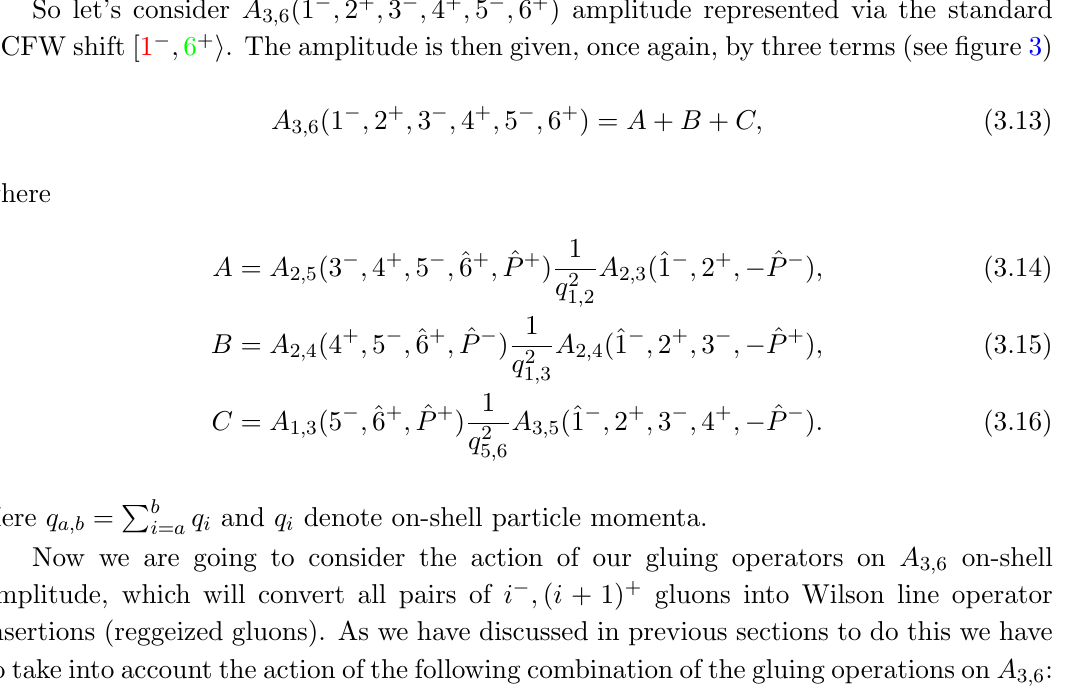
Figure 3 . The action of the gluing operators ˆ A ii representation of A 3 , 6 (1 − , 2 + , 3 − , 4 + , 5 − , 6 + )